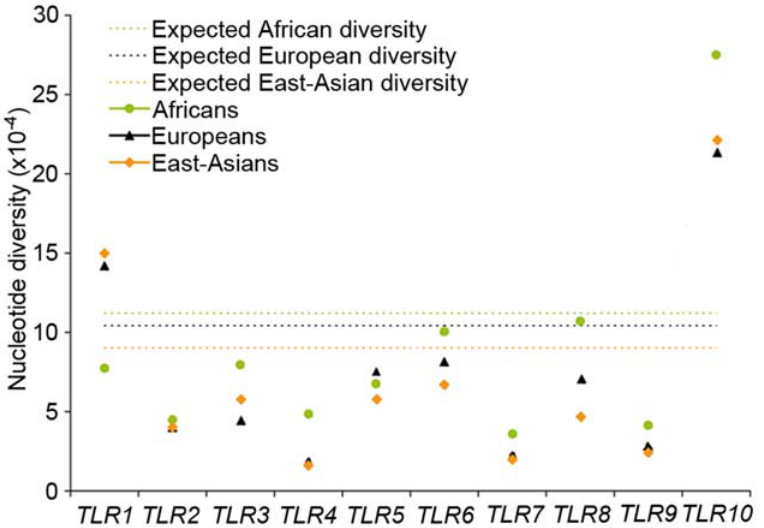
Figure 1. Global genetic diversity of the TLR family in human populations. Nucleotide diversity levels for the individual TLR genes in populations representing major ethnic groups. The expected diversity corresponds to the mean diversity levels observed for the 20 autosomal non- coding regions (‘‘neutral’’ regions) in each geographical area.